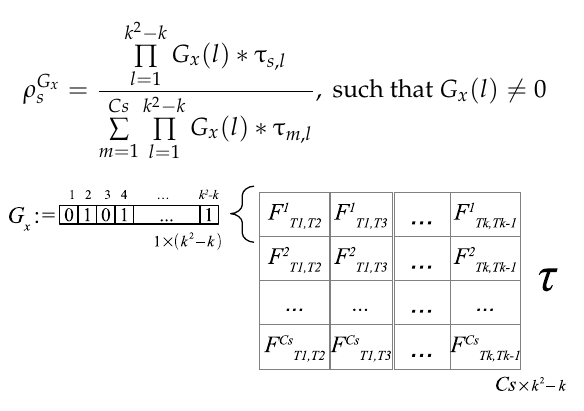
Figure 9. The G x genome